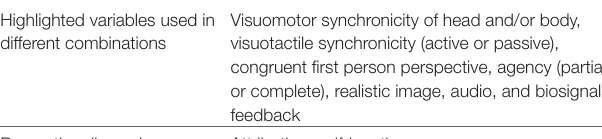
TABLe 4 | Highlighted variables and perceptive dimensions of Body Ownership Illusions. Highlighted variables used in different